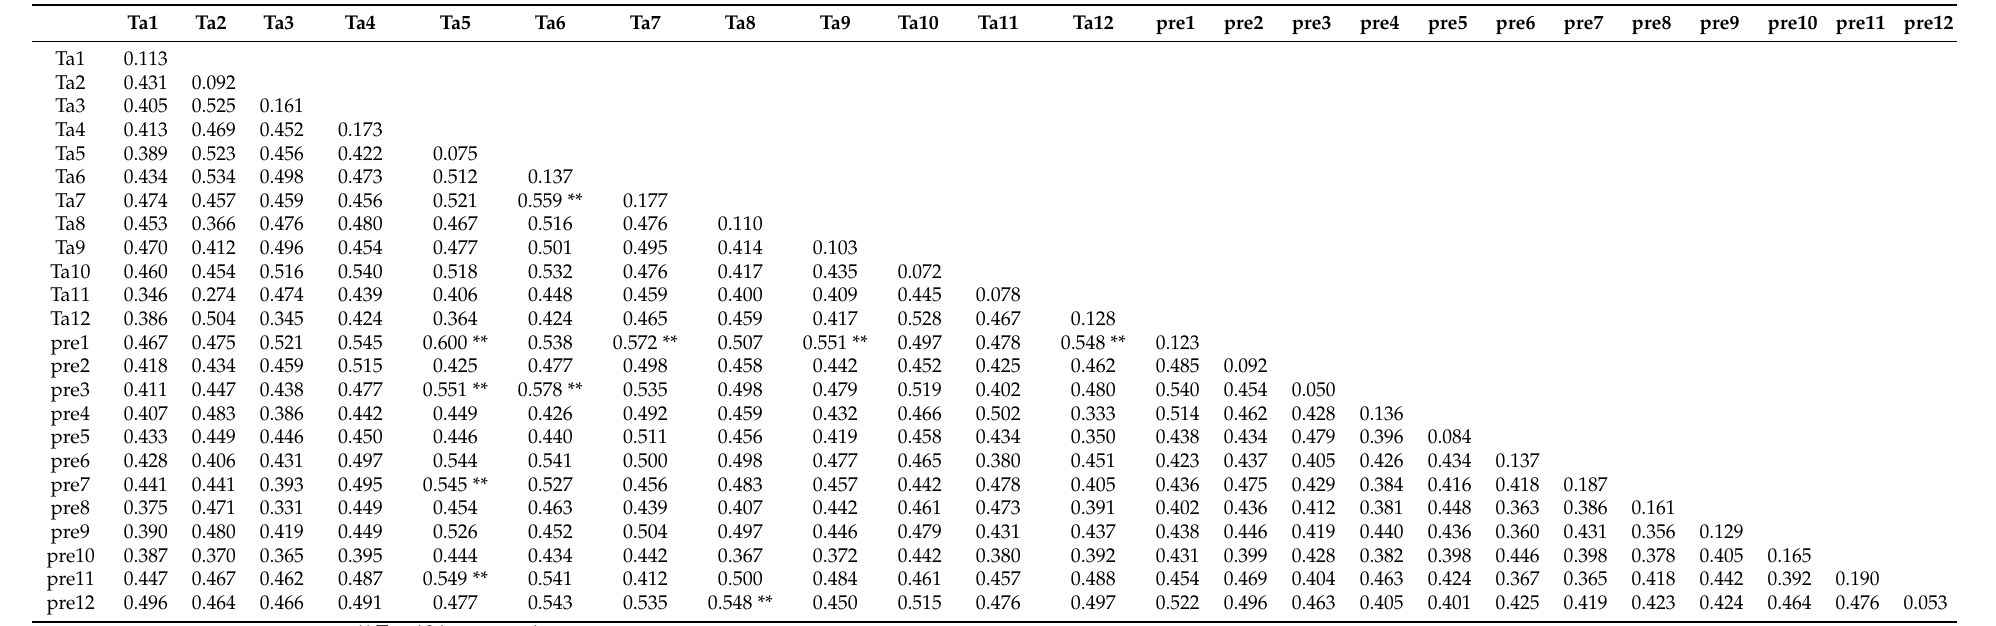
Table A2. Interpretation of EOS changes by multi-element